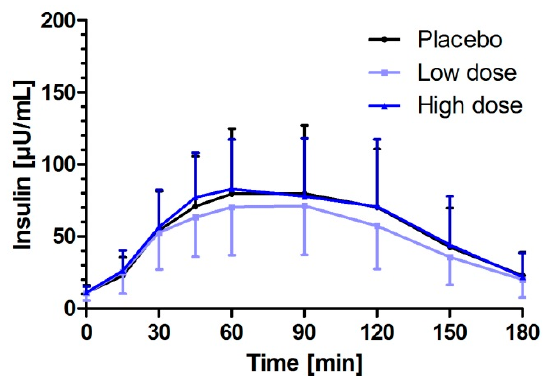
Figure 4. Insulin responses to low and high dose milk protein hydrolysate containing bioactive peptides consumed 15 min prior to a challenge meal. Data represent mean ± 95%